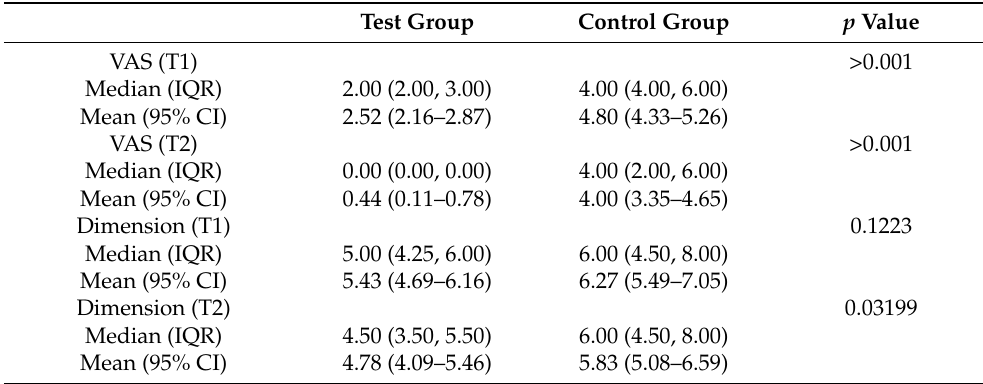
Table 3. Drop out patients at the last follow-up visit and proportion of patient who needed to take painkillers to relief